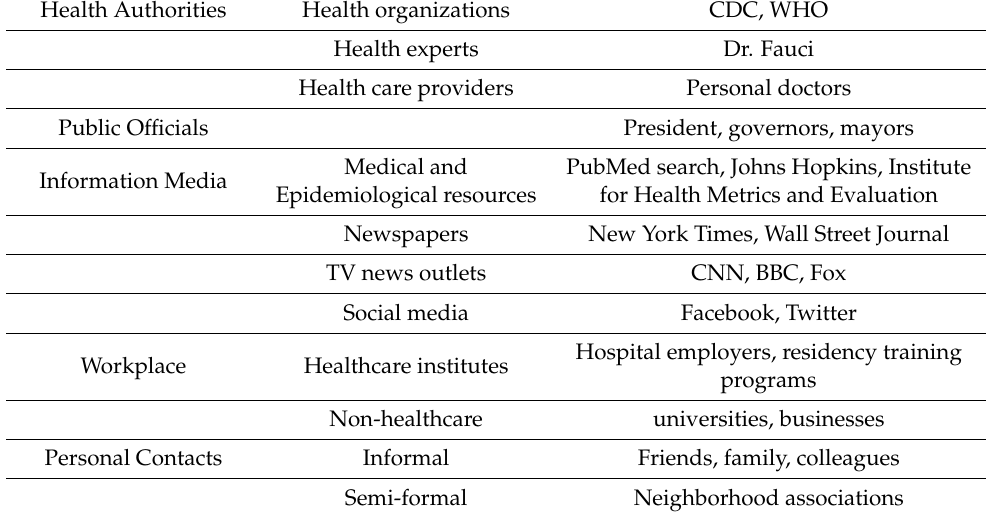
Table A1. Sources of